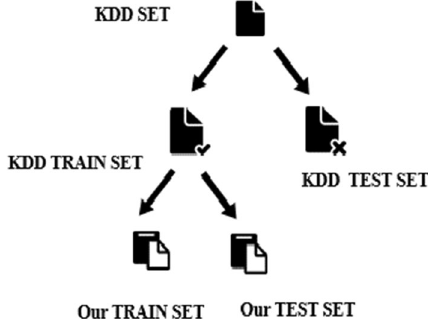
Fig. 7 The overall KDD dataset